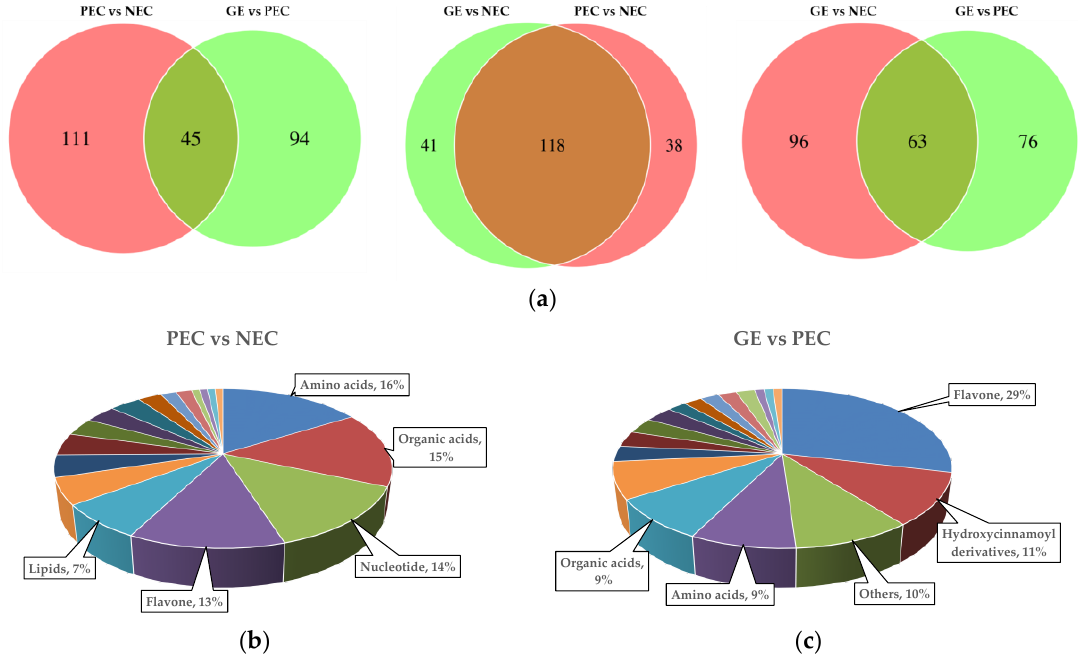
Figure 5. Differential metabolites commonly and specifically accumulated in PEC vs. NEC, GE vs. PEC, and GE vs. NEC. ( a ) Venn diagrams showing the distribution of DAMs in PEC vs. NEC, GE vs. PEC, and GE vs. NEC; ( b ) component analysis of DAMs accumulated specifically in PEC vs. NEC; ( c ) component analysis of DAMs accumulated specifically in GE vs. PEC. The top five specific DAMs are noted beside each graph. DAMs, differentially accumulated metabolites; NEC, nonembryogenic staged calli; PEC, primary embryogenic calli; GE, initiation staged embryos with globular-like enriched.